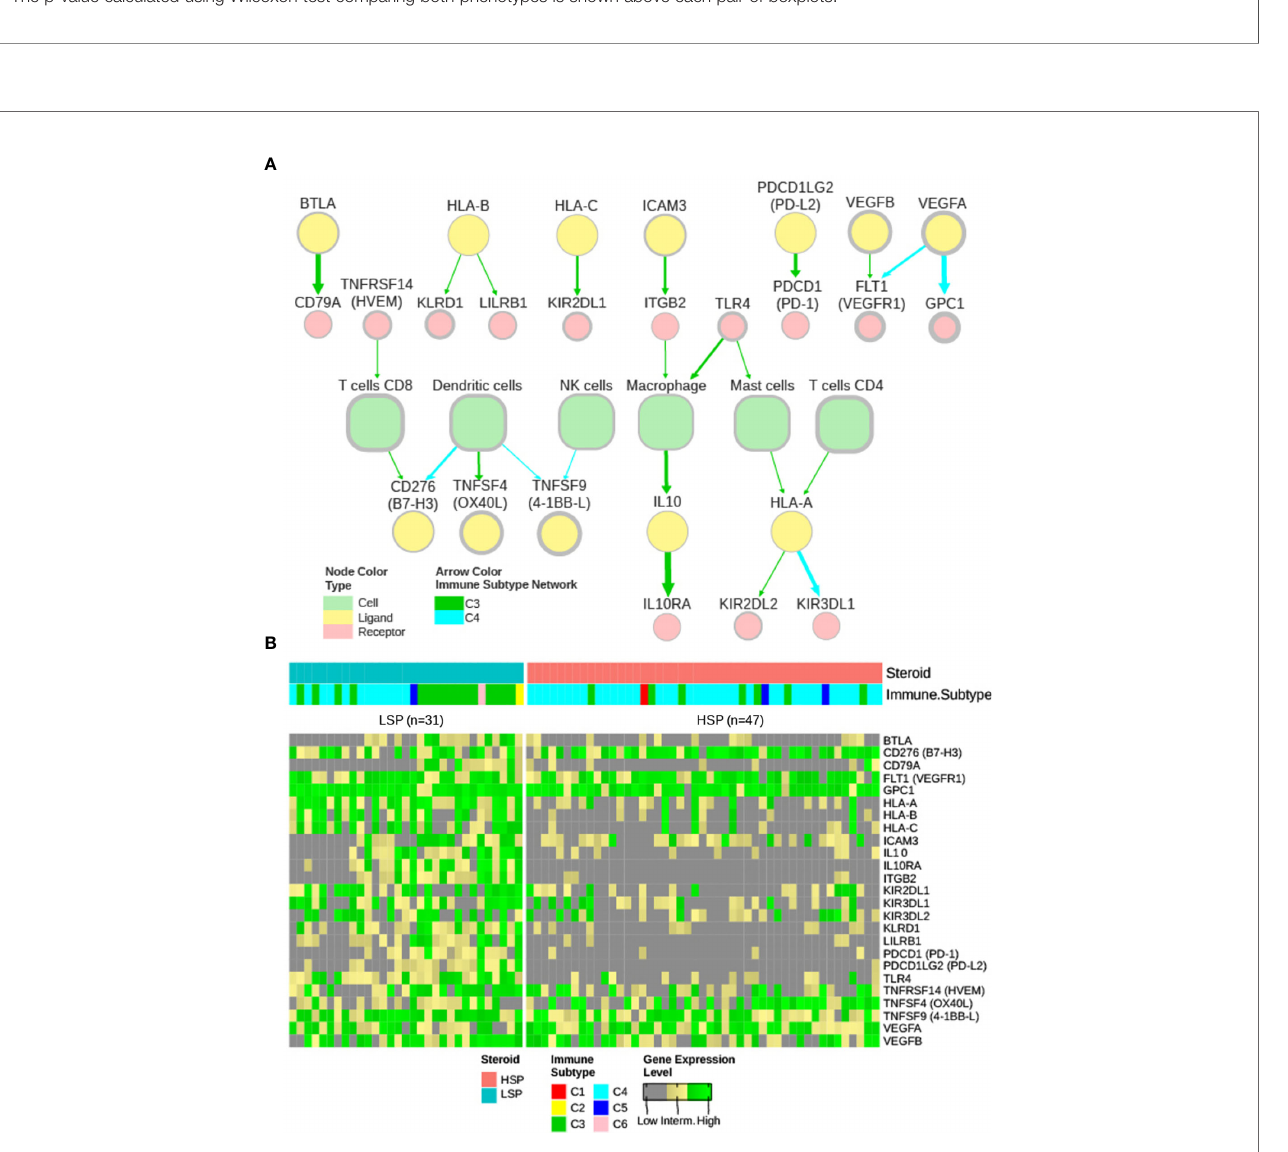
FIGURE 6 | Gene expression of immune modulators and Thorsson and colleagues ’ immune signatures. (A) Heatmap with column-wise z-scores for expression of immune modulator genes. The maximum and minimum z-scores for the color gradient is set at +2 and − 2 standard deviations from the mean. Each column represents a patient. The order from Figure 5A was maintained. The p-value for the DE analysis for each gene determined using the Wald ’ s test is represented in the right. The − log10 (p-value) color gradient is set as white up to the minimum value of 2 and the maximum is set to 10; however, its range exceeds 20 for GZMA, CCL5 , and CD40LG . The absolute p-values for all differentially expressed genes can be found in Supplementary Table 1 . *Clinical cortisol excess and the molecular classi fi cation were described by Zheng et al. (5) and presented in the top annotation. **Immune subtype classi fi cation and the fi ve molecular immune signatures rescaled to a range of 0 to 1 were according to Thorsson et al. (11) and are shown in the top annotation. (B) Boxplot comparing LSP and HSP for leukocyte fractions and the fi ve immune signatures associated with lymphocyte in fi ltrate scores, macrophage regulation, wound healing, IFN- g response, and TGF-ß response according to Thorsson et al. (11). The scores for each of the fi ve signatures are rescaled to a range of 0 to 1 (y-axis). The density plot shows the distribution according to the immune subtypes C3 (green) and C4 (cyan). Each sample is shown in a rug plot and colored according to HSP and LSP classi fi cation.